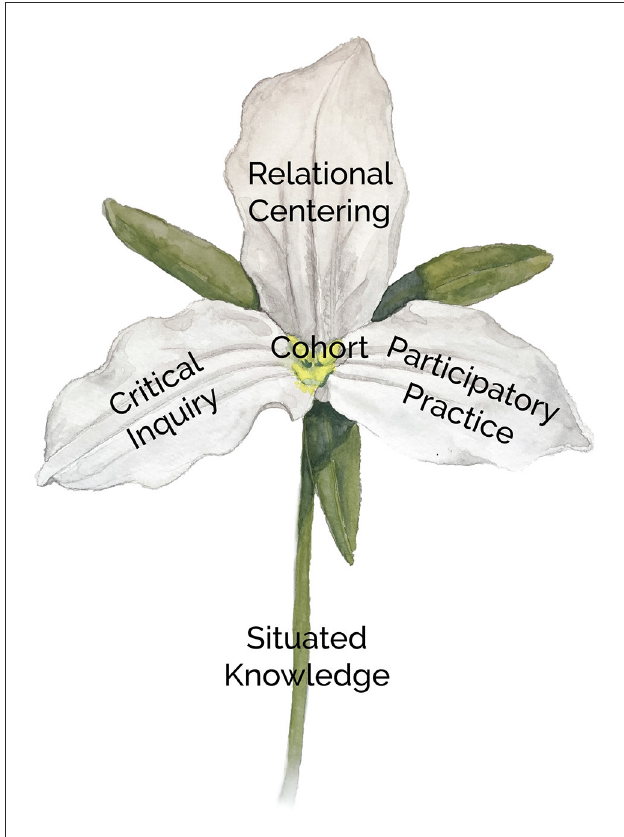
FIGURE3 Conceptualizing the agroecology pedagogy model as Trillium grandiflorum is an opportunity to expand the imaginative possibilities of ongoing, iterative agroecology program development.